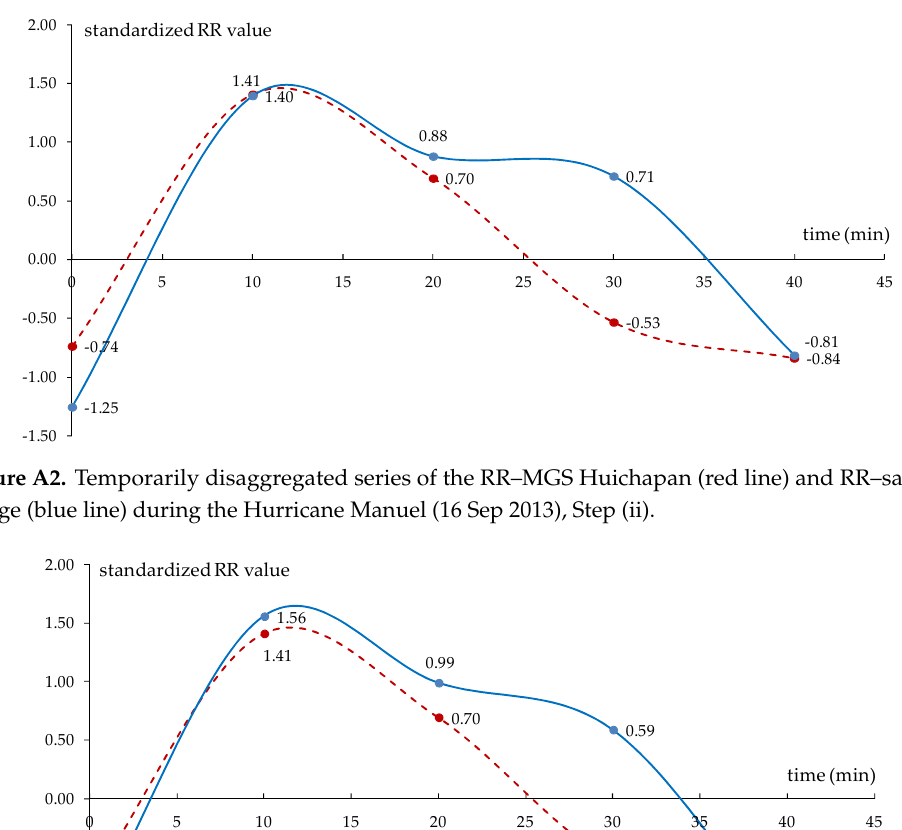
Figure A1. Temporarily disaggregated series of the RR–MGS Huichapan (red line) and RR–satellite image (blue line) during the Hurricane Manuel (16 Sep 2013), Step (i).